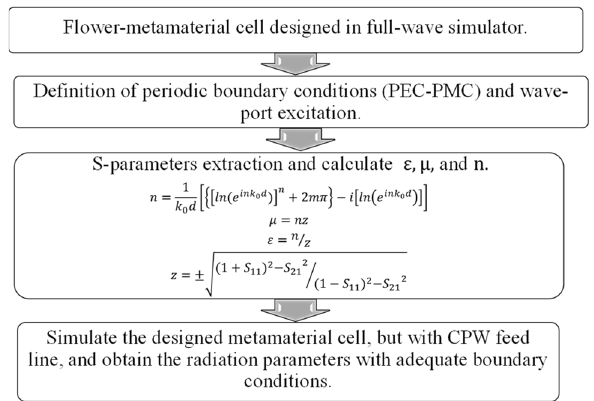
Figure 10. Methodology for design and extraction of parameters of unit cell